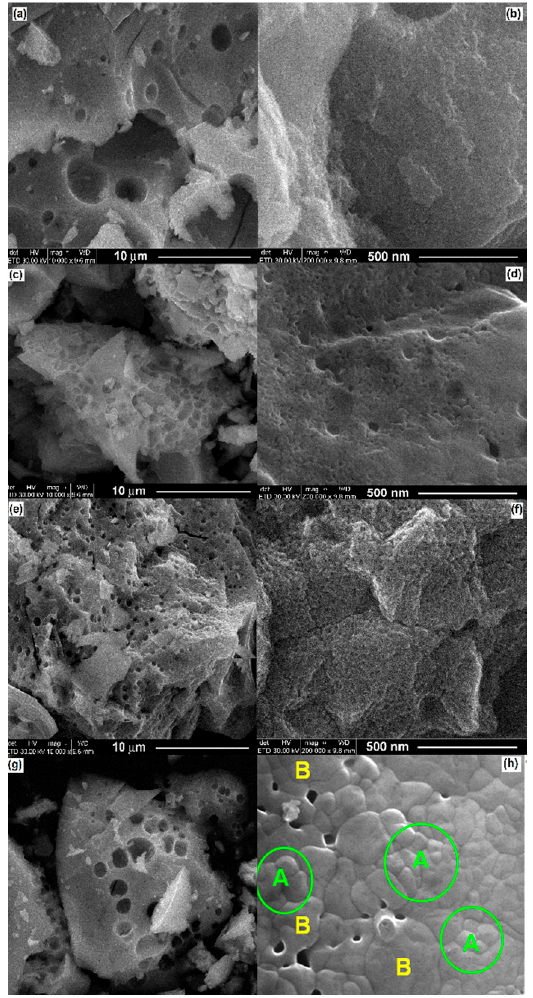
Figure 5. FE-SEM overall ( a , c , e , g ) and detail ( b , d , f , h ) images of LaFeO 3 powders calcined at various temperatures: ( a , b )—550 ◦ C, ( c , d )—600 ◦ C, ( e , f )—700 ◦ C, and ( g , h )—800 ◦ C (green circles A—groups of nano-sized grains, yellow B—larger grains formed by the coalescence of the smaller ones).